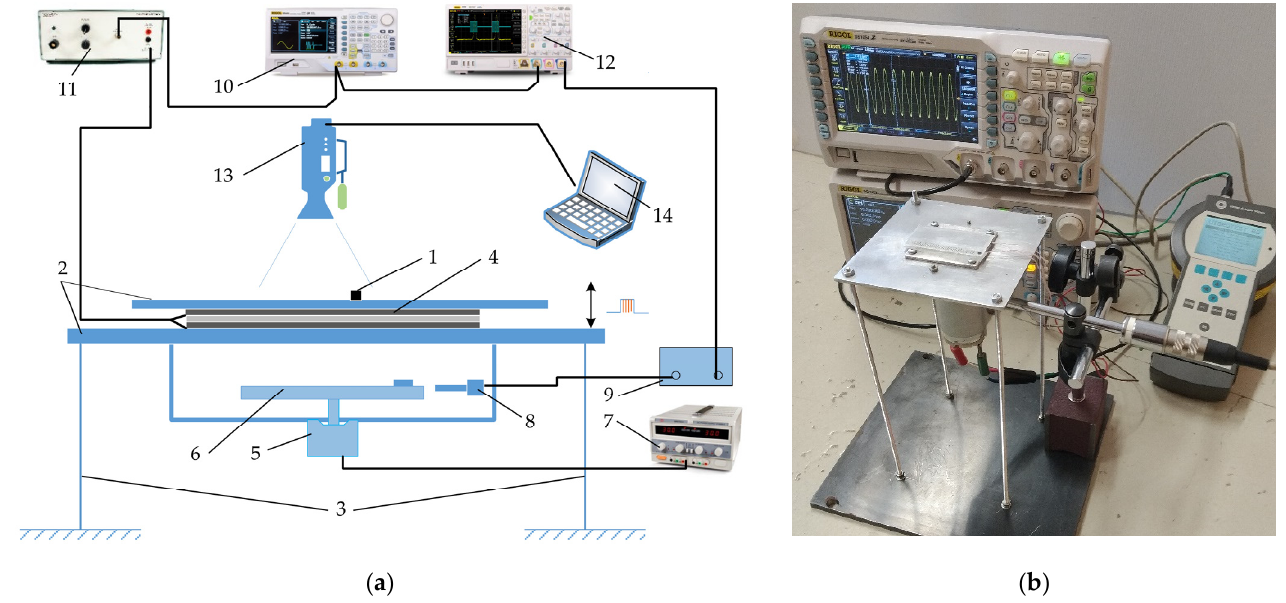
Figure 8. Experimental setup for manipulation of parts on a horizontal circularly oscillating platform with dynamic dry friction control: ( a ) scheme where (1) part to be manipulated; (2) platform; (3) elastic rods; (4) piezoelectric actuator; (5) electric motor; (6) eccentric mechanism; (7) electric motor power supply; (8) optical reference sensor, (9) vibration analyzer; (10) arbitrary waveform generator; (11) high frequency vibration amplifier; (12) digital oscilloscope; (13) video camera; (14) computer; ( b ) general view of the platform for nonprehensile manipulation with dry friction control.